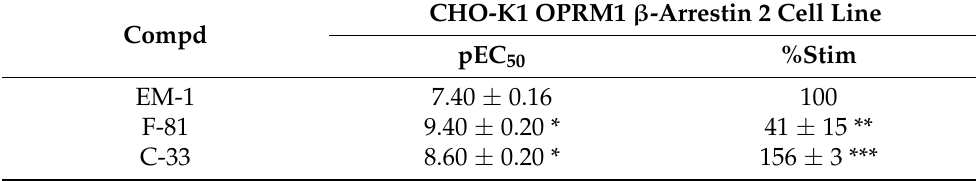
Table 2. Ligand induced β -arrestin recruitment in CHO-K1 OPRM1 ( µ -opioid receptor (MOP))/ β - arrestin 2 PathHunter assay.